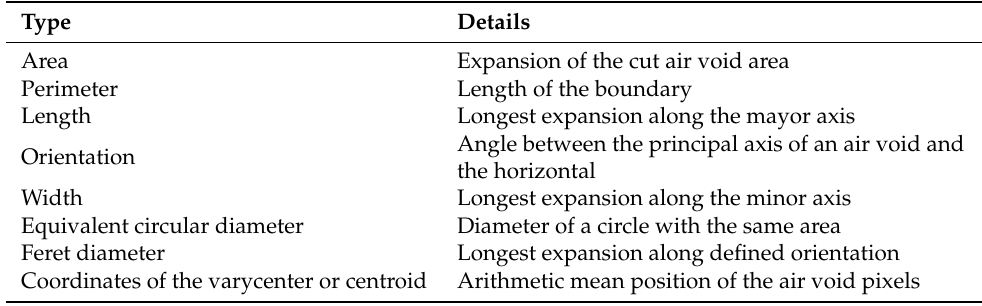
Table 1. Data types from the evaluation.